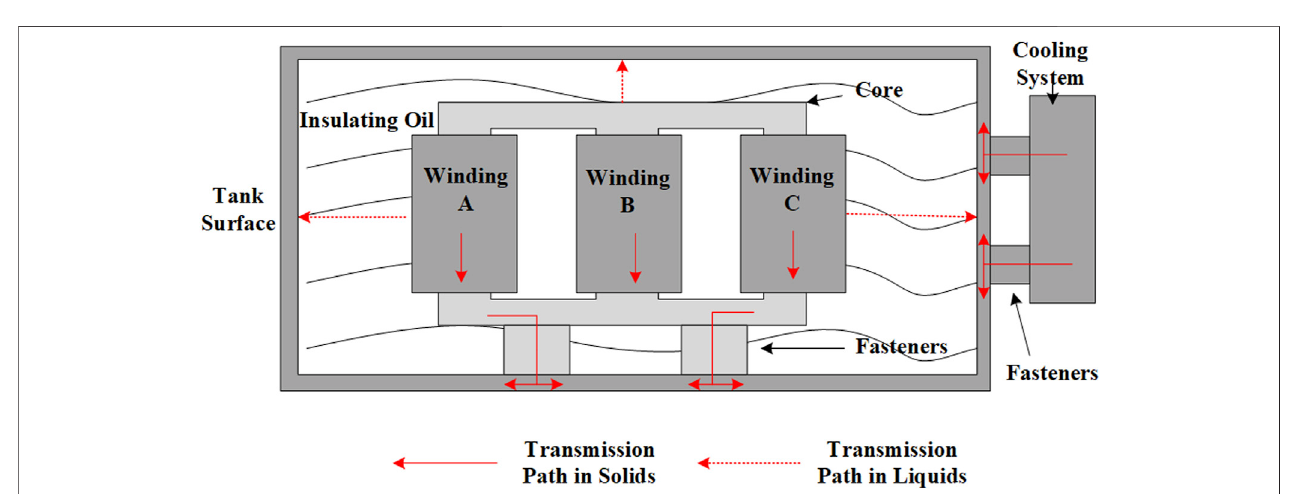
FIGURE 2 | Typical transmission path of transformer vibrations from different origins.